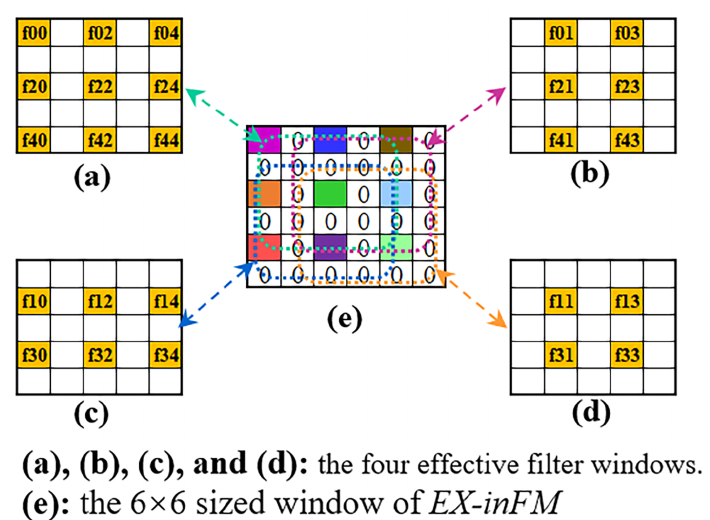
Figure 4. An illustration of picking the effective filter values in alignment to the non-zero grids in inFM .